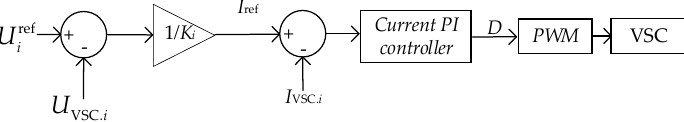
Figure 4. I-U droop control diagram.